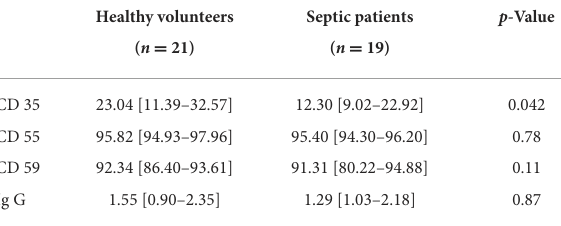
TABLE 2 Comparisons of membrane receptor proteins and Ig G at ICU